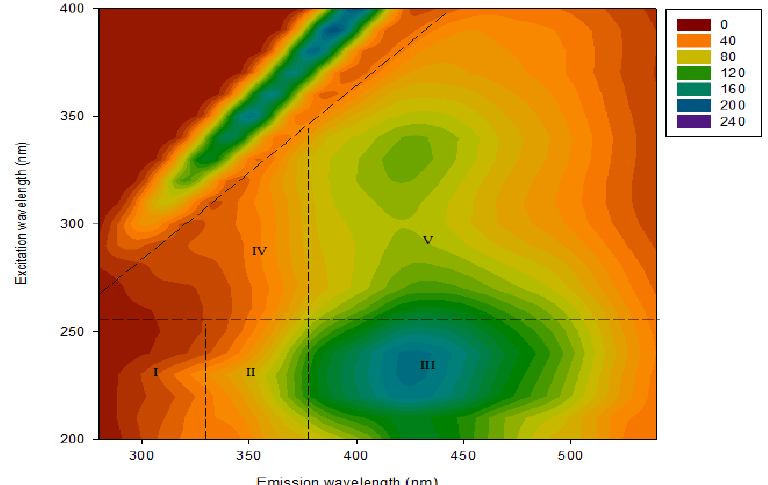
Fig. 3: Area percentage of organic fraction distribution during the bionet expressed by (a) HPSEC-OCD and (b) HPSEC-UVD with peakfitting software